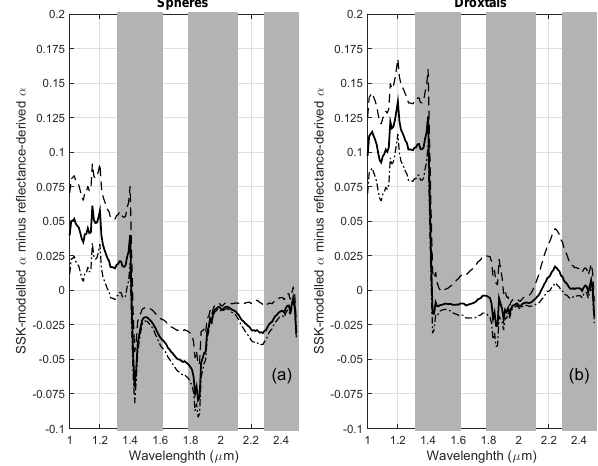
Figure 10. Mean difference between model- and reflectance- derived albedo for spherical (a) and droxtal (b) particle shape. Shaded areas correspond to wavebands where the signal-to-noise ratio of the reflectance measurements was very low. Dashed black lines mark the 5 and 95% confidence limits of the mean bias (see Appendix